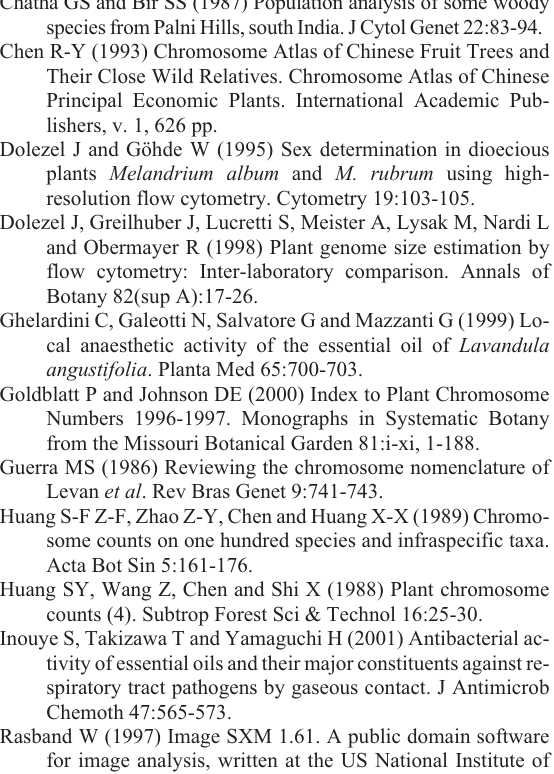
Table 1 - Analysis and classification of the chromosome morphology of Aniba rosaeodora (2n = 24). Chrom